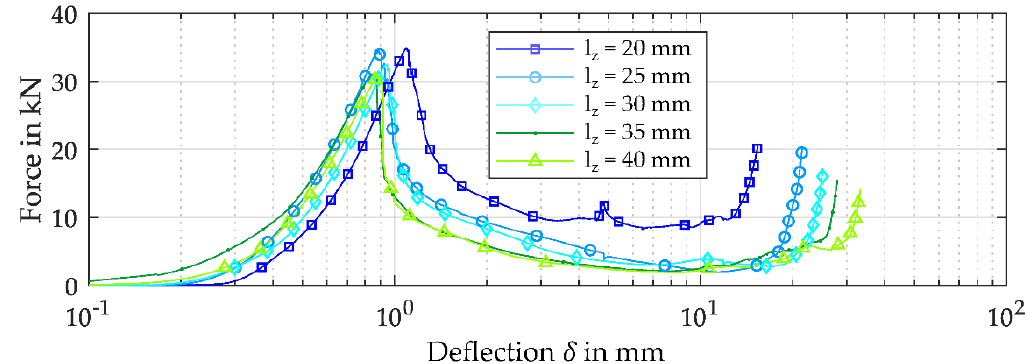
Figure 12. Deformation of honeycomb core structure samples under compression load.